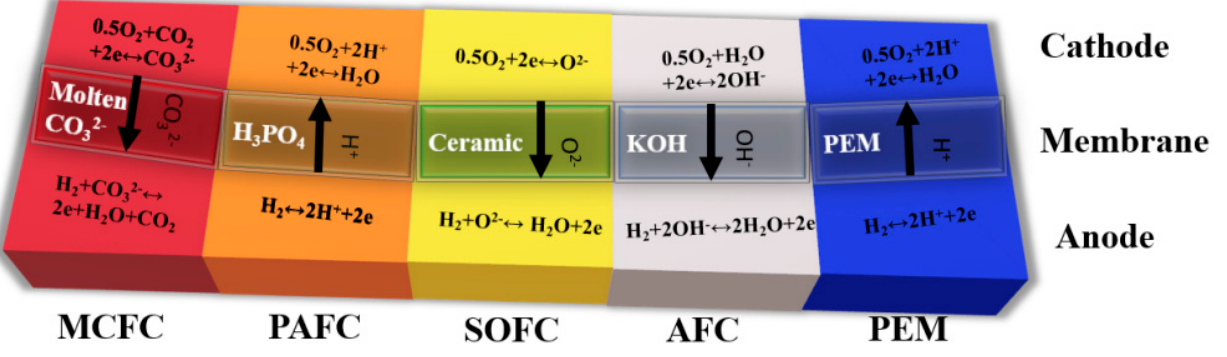
Figure 6. Diagram of the cell with different variants.